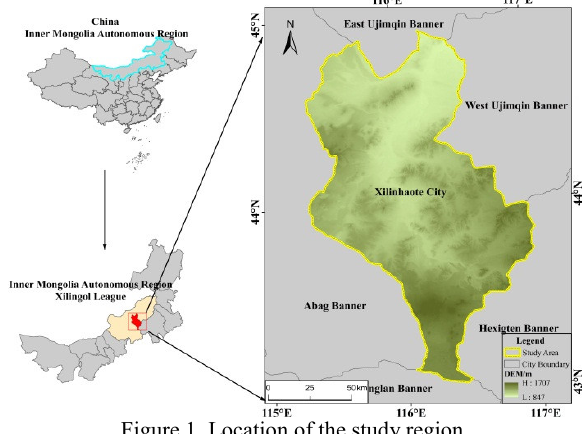
Figure 1. Location of the study region